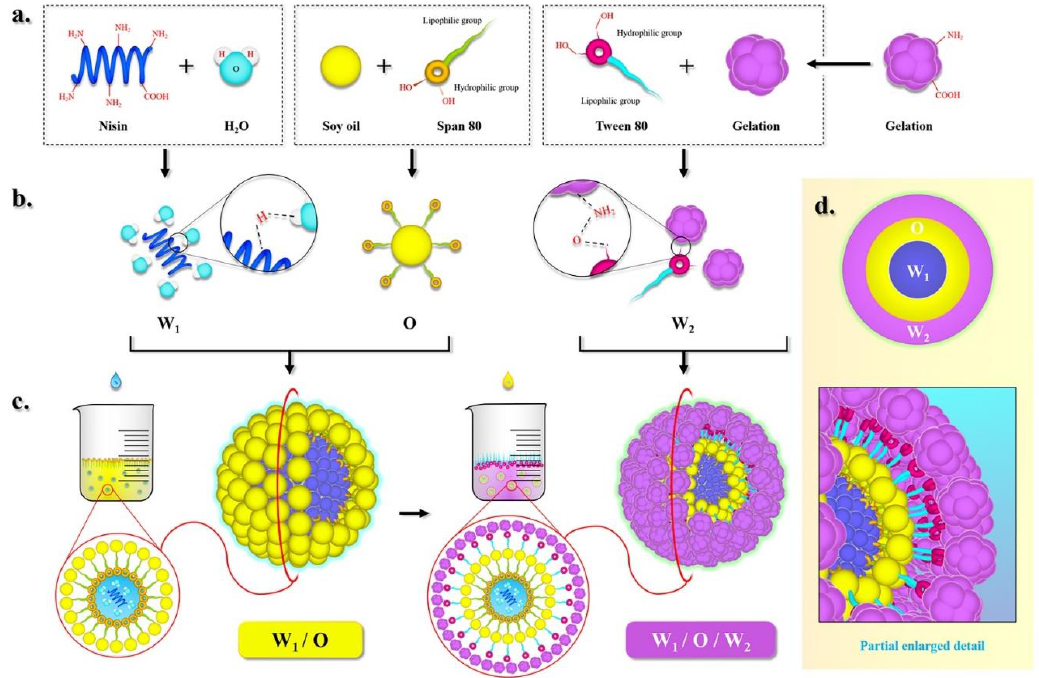
Figure 1. The mechanism by which soy oil/gelatin encapsulates nisin, ( a ) dissolve; ( b ) microscopic reaction; ( c ) macroscopic reaction; ( d ) particle enlarged detail.